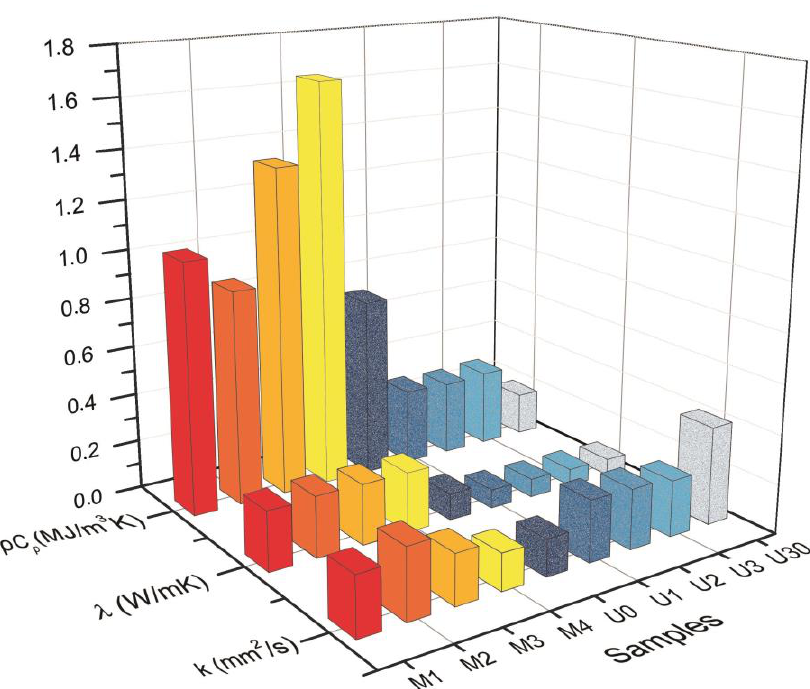
Figure 11. Thermal diffusivity ( k ), conductivity (λ), and volumetric specific heat capacity ( 𝜌 C p ) of the samples.